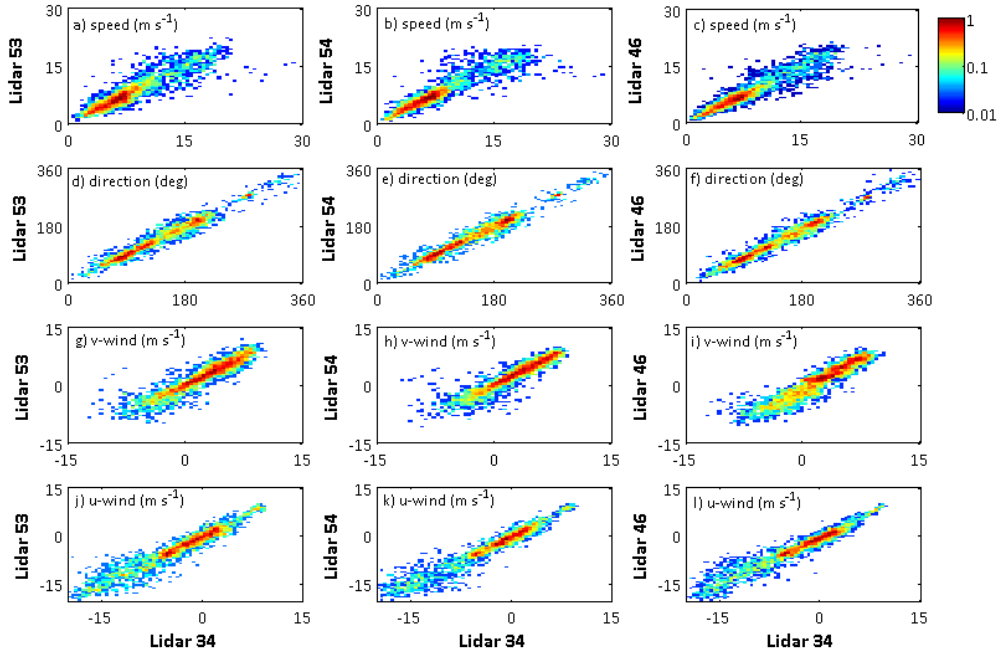
Fig. 8. Frequency of horizontal wind speed and direction, and v and u components of velocity measured during the second measurement campaign in Helsinki during the period 24 November–9 December 2012. Left panels show comparison of lidar 53 to lidar 34; middle panels compare lidar 54 versus 34; right panels compare lidars 46 and 34. Each point is an average over 15min, and all available data between 150 and 1050m are shown. Pixel width for velocity and speed was 0.5ms − 1 , and for direction 5 ◦ .